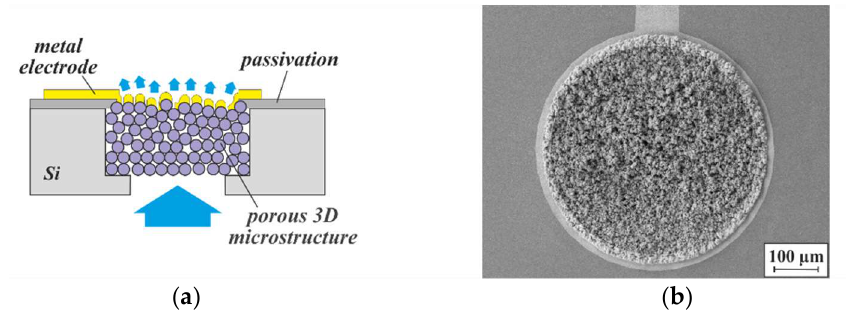
Figure 23. ( a ) Schematic concept of a flow-through 3D sensor with a thin-film electrode deposited on top of a porous 3D microstructure, and ( b ) SEM micrograph of the top side of such a structure. The electrode consists of sputtered Au. The porous 3D microstructure, 500 µm in diameter and ~500 µm deep, was agglomerated from 5 µm NdFeB particles by 75 nm ALD-Al 2 O 3 .